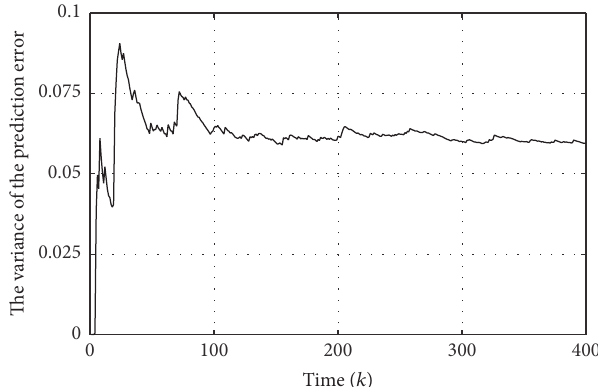
Figure 8: Evolution curve of the variance of the prediction error 𝜎 2 (𝑘) . 𝜀